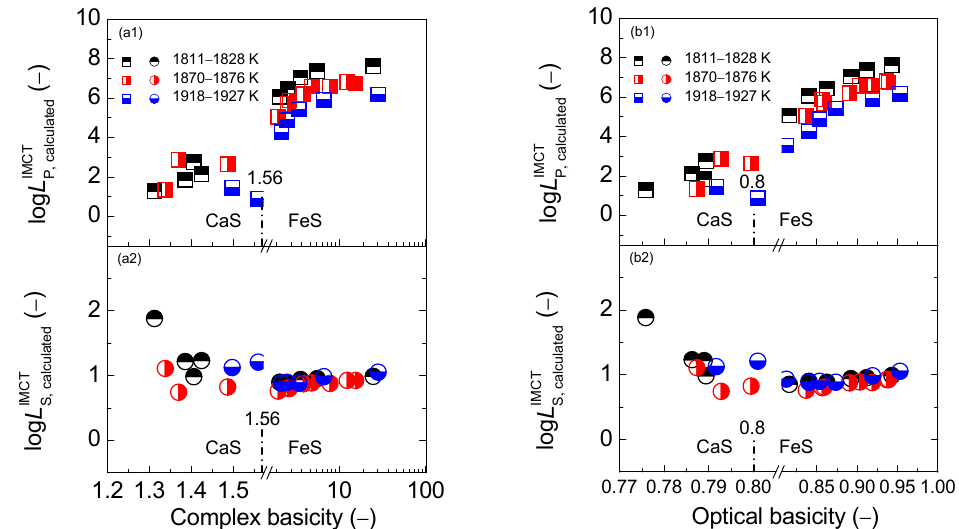
Figure 6. Relationship of simplified complex basicity ( % CaO ) / [( % P 2 O 5 ) + ( % Al 2 O 3 )] ( a ) or optical basicity Λ ( b ) against the calculated [3] phosphorus distribution ratio log L IMCT model in the first layer or calculated [4] sulfur distribution ratio log L IMCT model in the second layer for CaO–FeO–Fe 2 O 3 –Al 2 O 3 –P 2 O 5 slags equilibrated with liquid iron over a temperature range of 1811 to 1927 K (1538 to 1654 ◦ C), respectively.